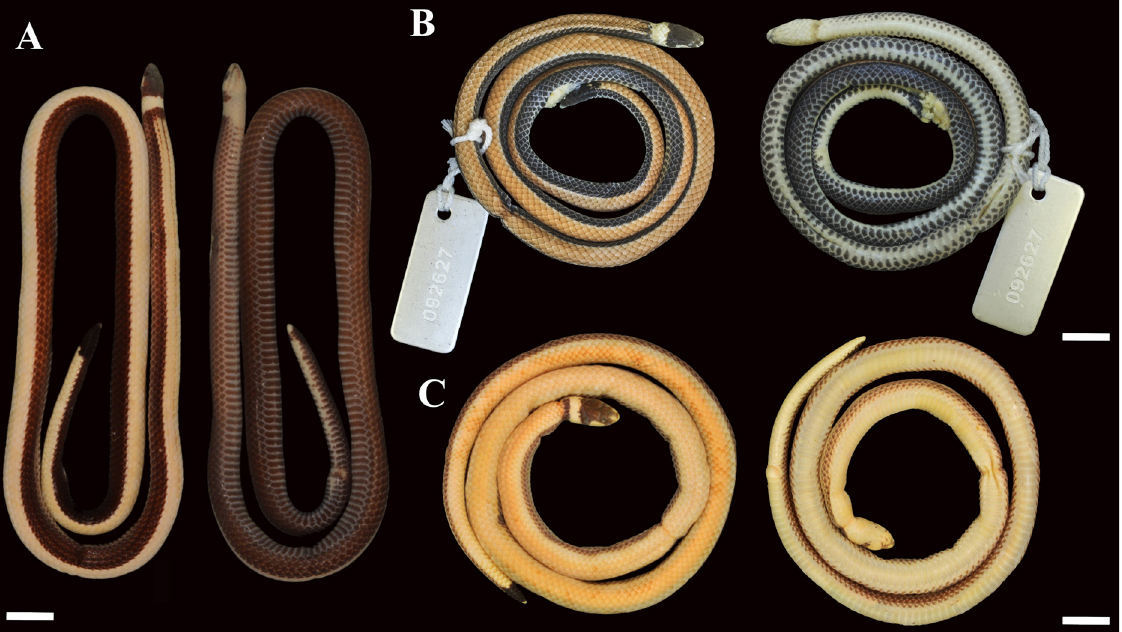
C . Apostolepis cerradoensis Lema, 2003, holotype from Minaçu, Goiás, Brazil (MCP 15219). Notice the varying degrees of ventral melanism polymorphism, ranging from uniformly black, to black and cream, and uniformly cream. Photograph credits: Douglas Sebben (A, C), Rafael P. Benetti (B). Scale bars = 10